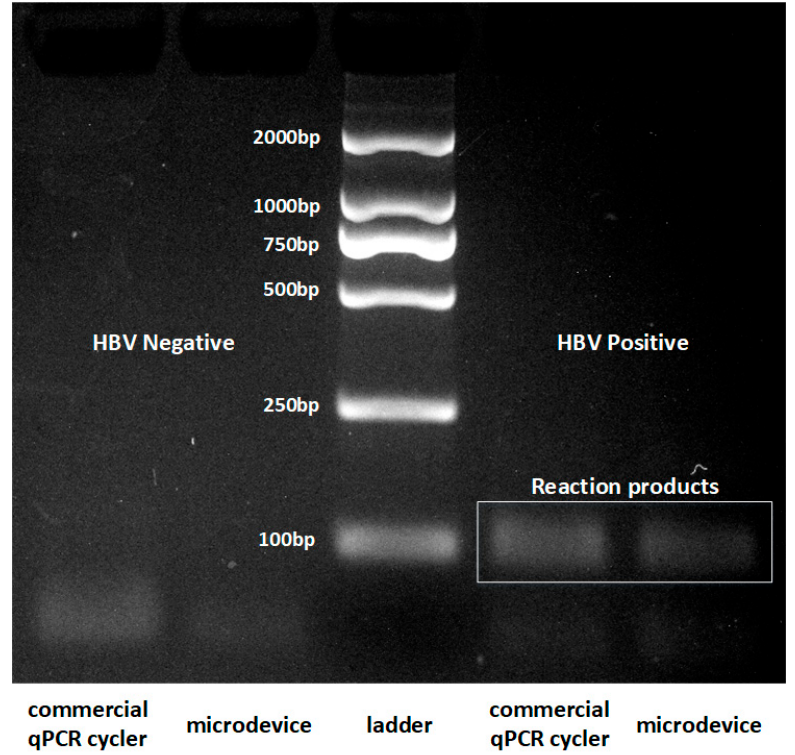
Figure 7. The electrophoretogram of the examination of hepatitis B virus.